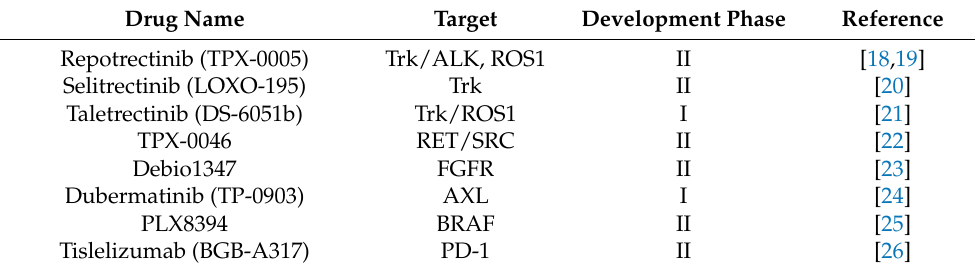
Table 1. Select tissue-agnostic developments in clinical